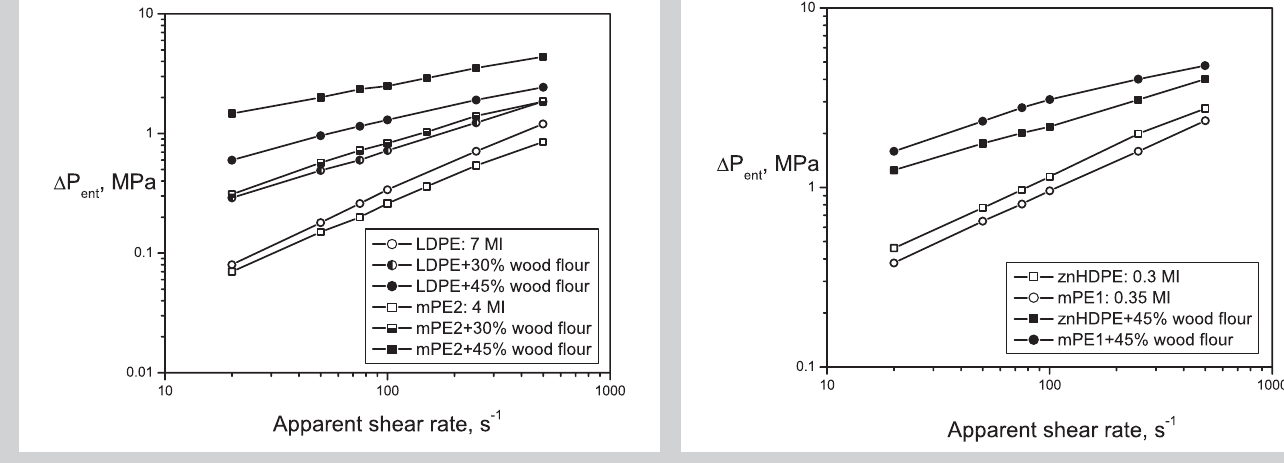
Figure 4 (left): Entrance pressure loss as a function of the apparent shear rate of the high melt index polyethylene/wood flour composites. Figure 5: Entrance pressure loss as a function of the apparent shear rate of the low melt index polyethylene/wood flour